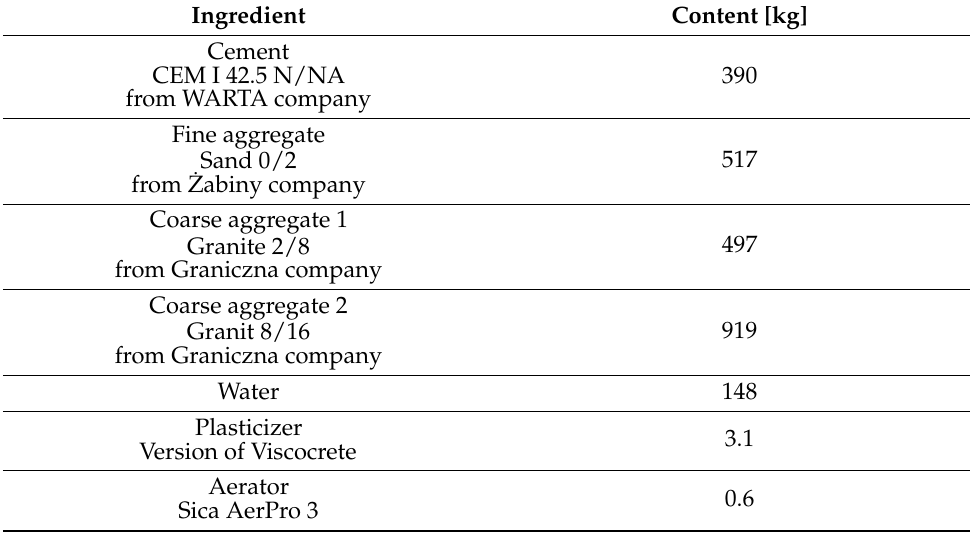
Table 3. Concrete mix design for track slab (Z1).